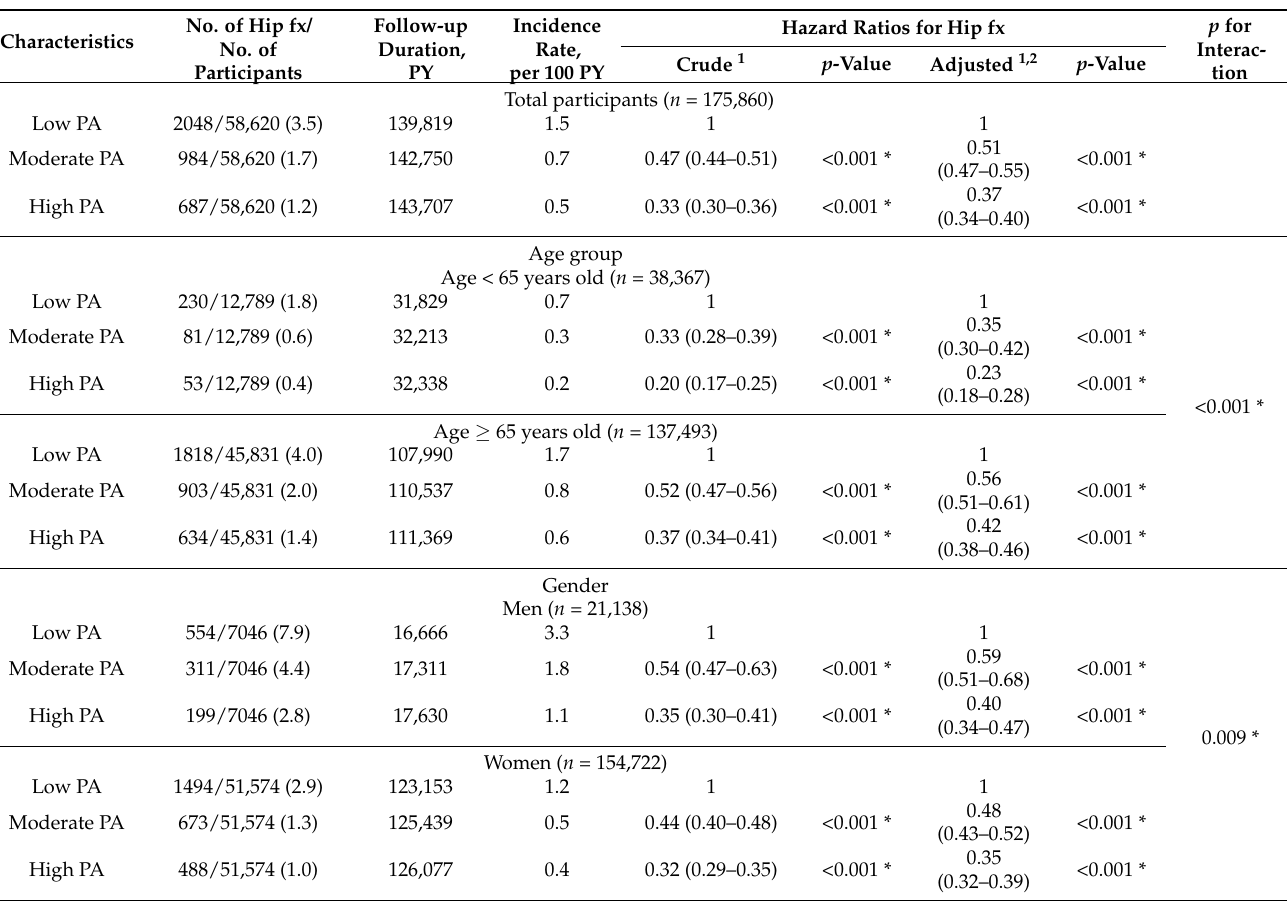
Table 3. HR (95% CIs) for hip fx in the PA groups with subgroup analyses according to age and